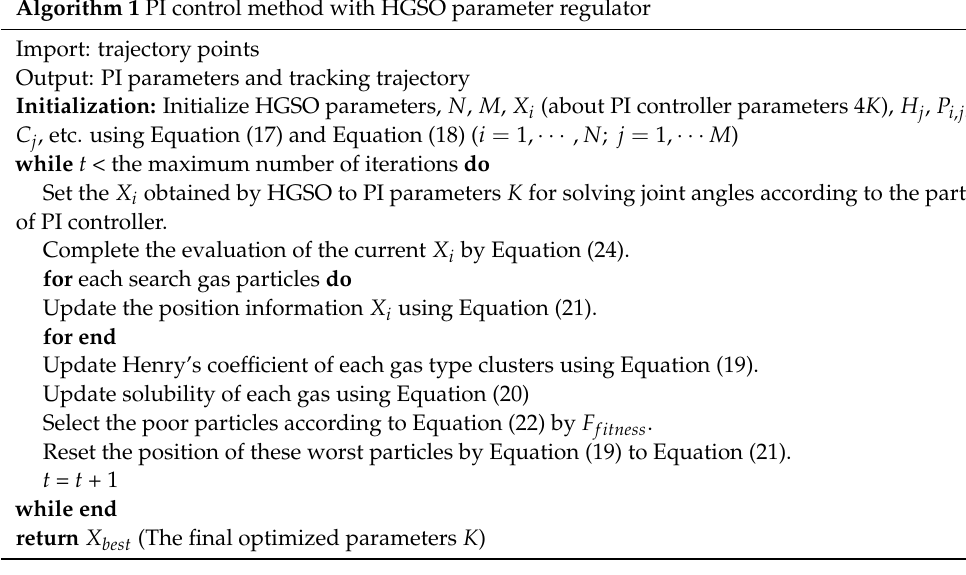
Algorithm 1 PI control method with HGSO parameter